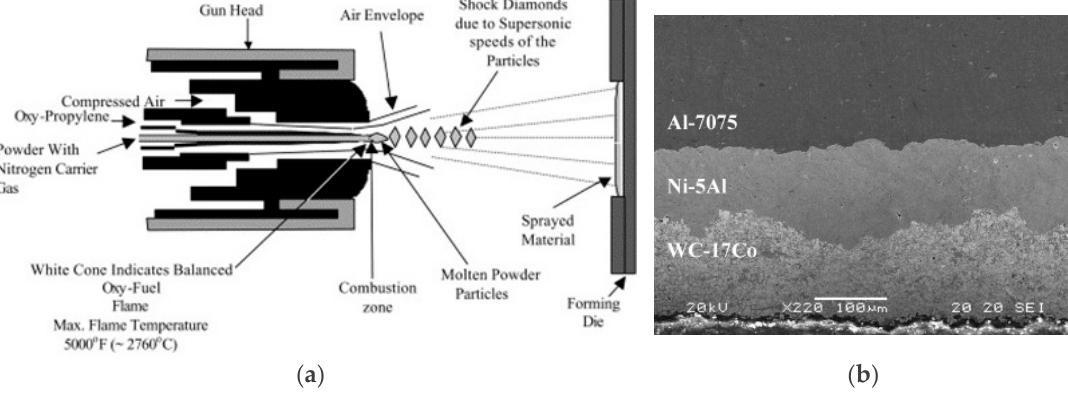
Figure 9. ( a ) Schematic setup of a high-velocity oxy-fuel (HVOF) coating system [89] and ( b ) cross-